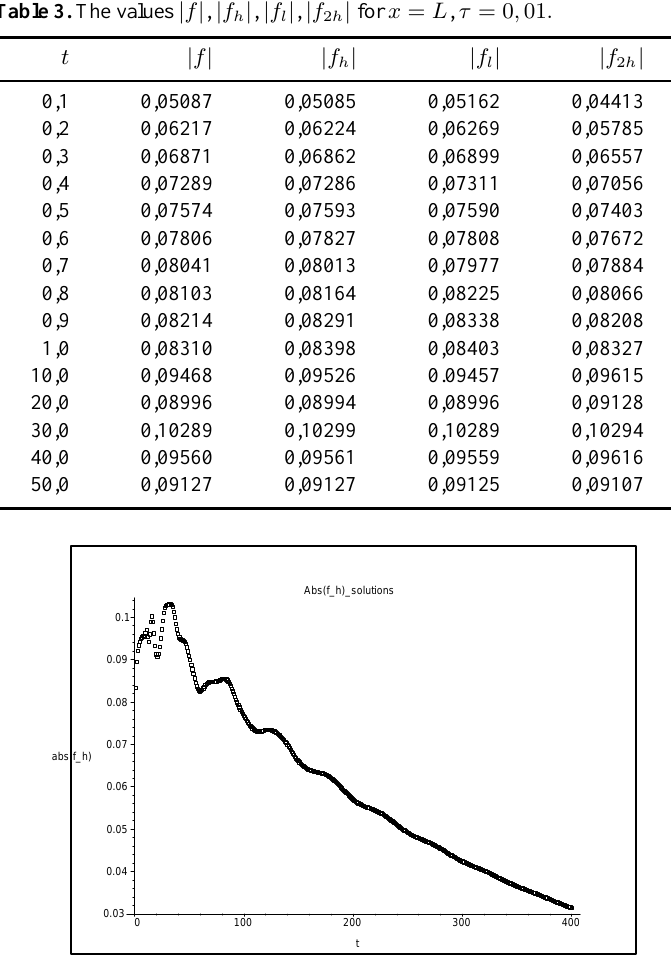
Figure 2. Solution of the grid problem j f h j , N = 750 , x =